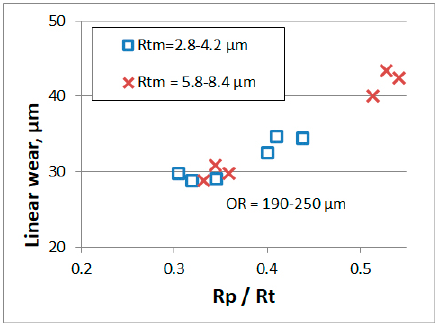
Figure 20. Relation between the emptiness coefficient and the cylinder wear of the engine under artificially increased dustiness conditions, for various initial values of roughness amplitude Rt parameter, adapted from [189].